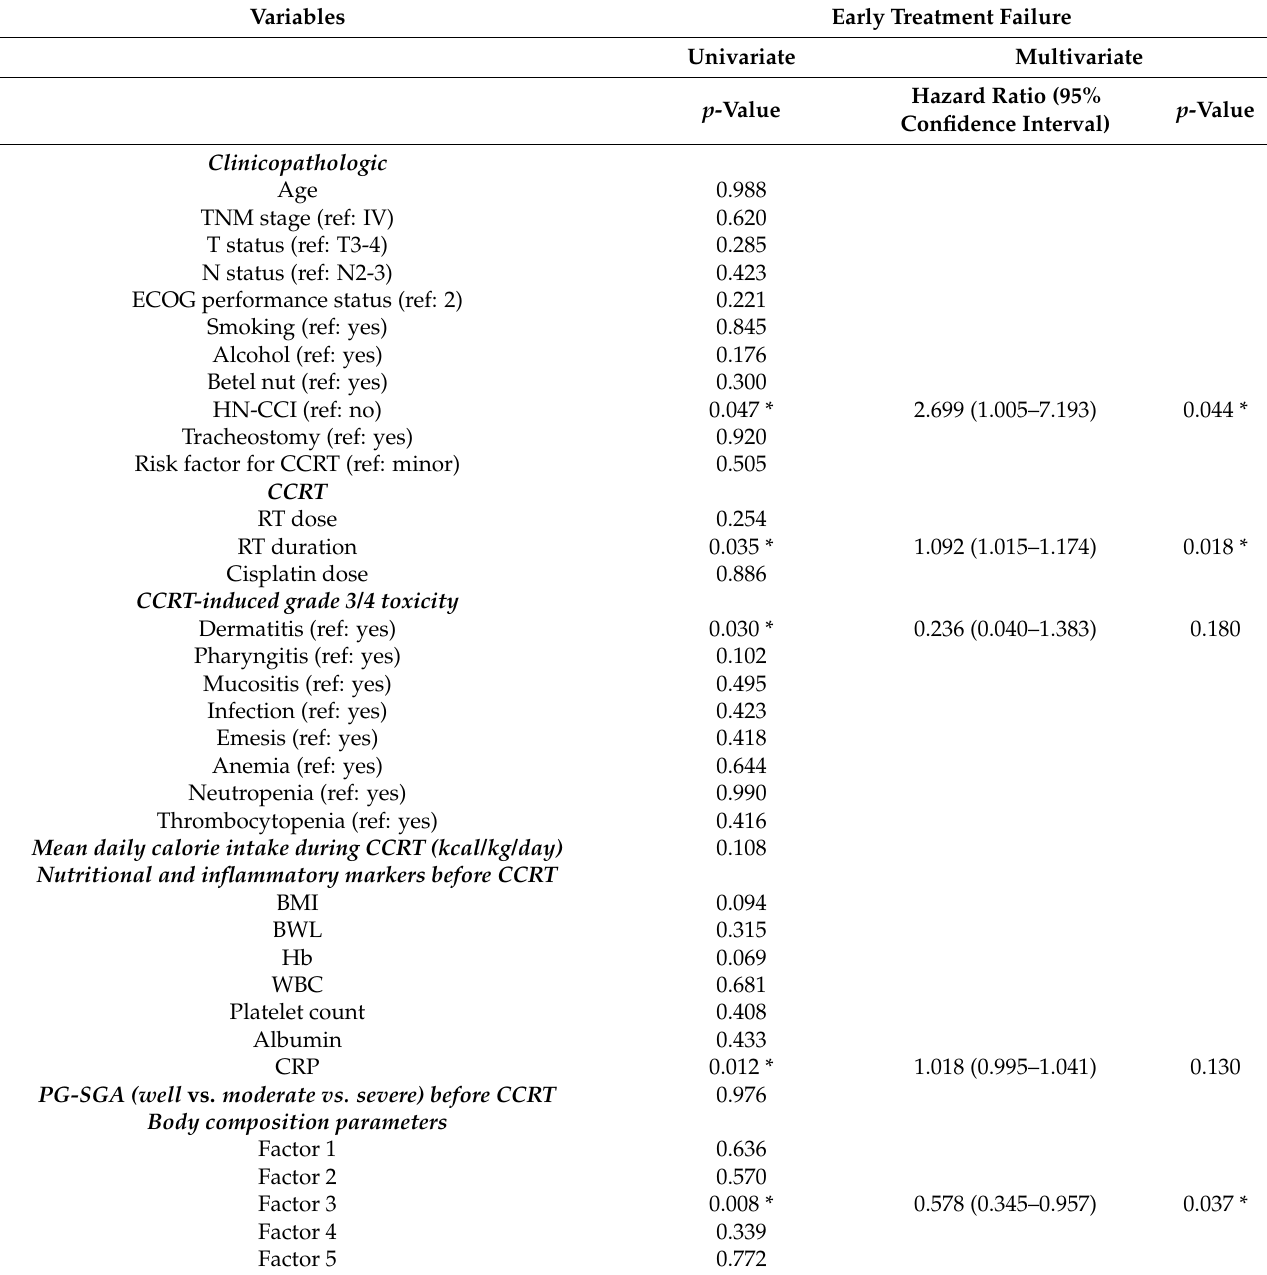
Table 4. Univariate and multivariate Cox regression analyses of factors associated with early treatment failure rate of 69 oral cavity cancer patients following CCRT